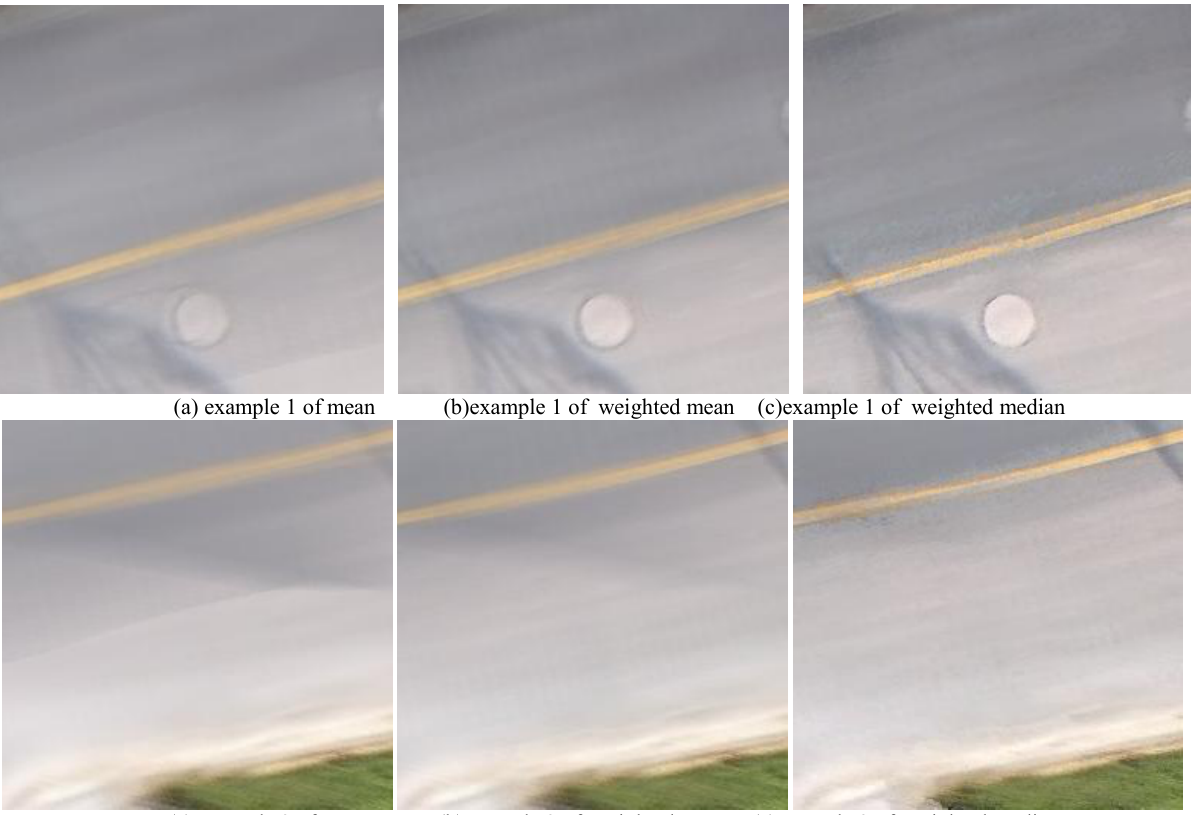
Fig.5. result of weighted median algorithm and the contrast to the result of mean algorithm and weighted mean